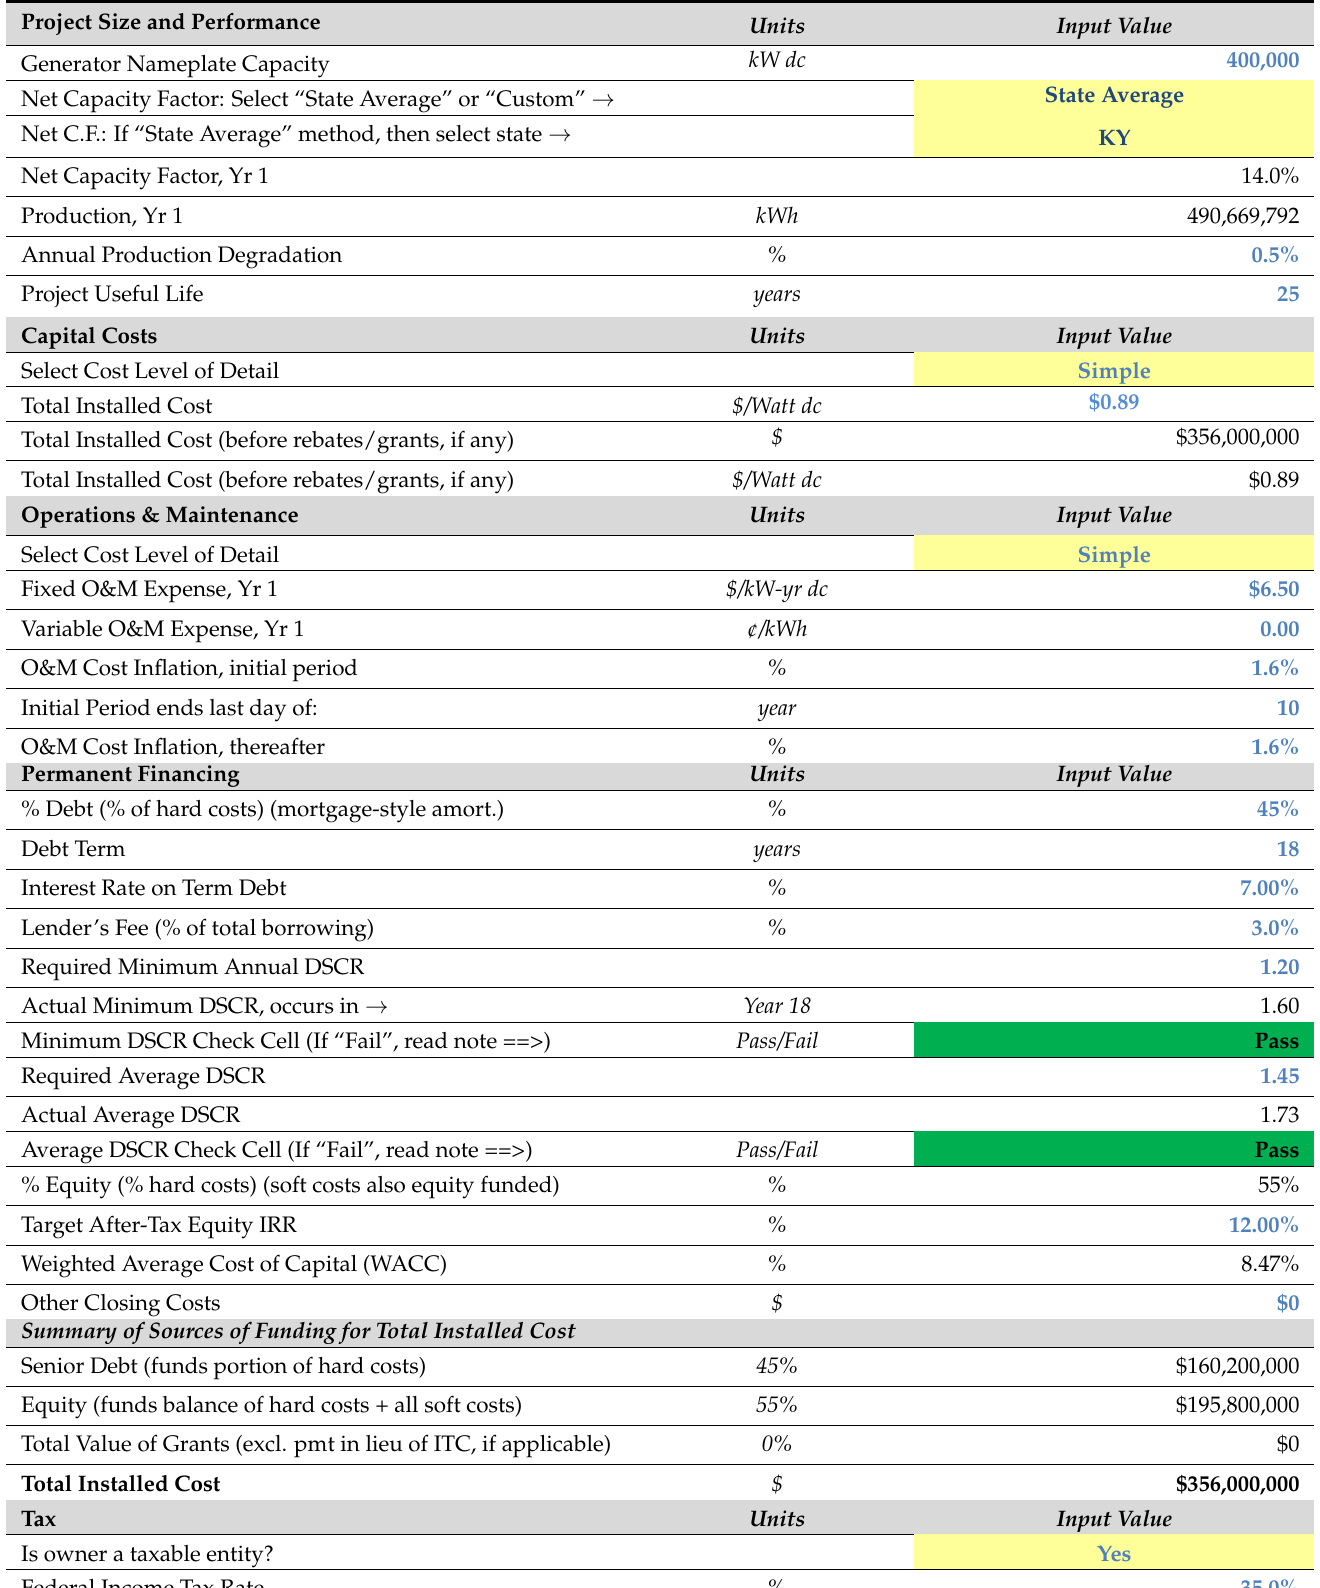
Table A2. CREST Example